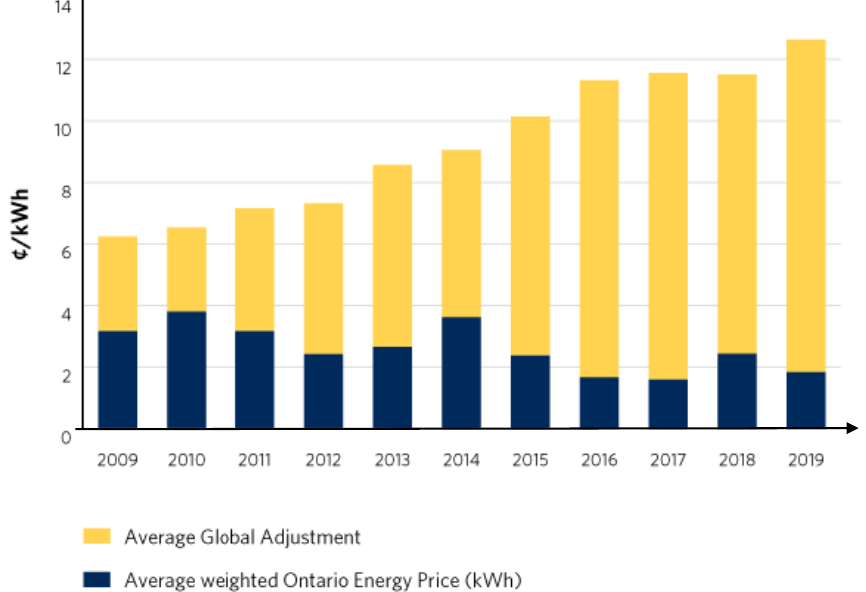
Figure 1. Historical Ontario average global adjustment price and average weighted energy price